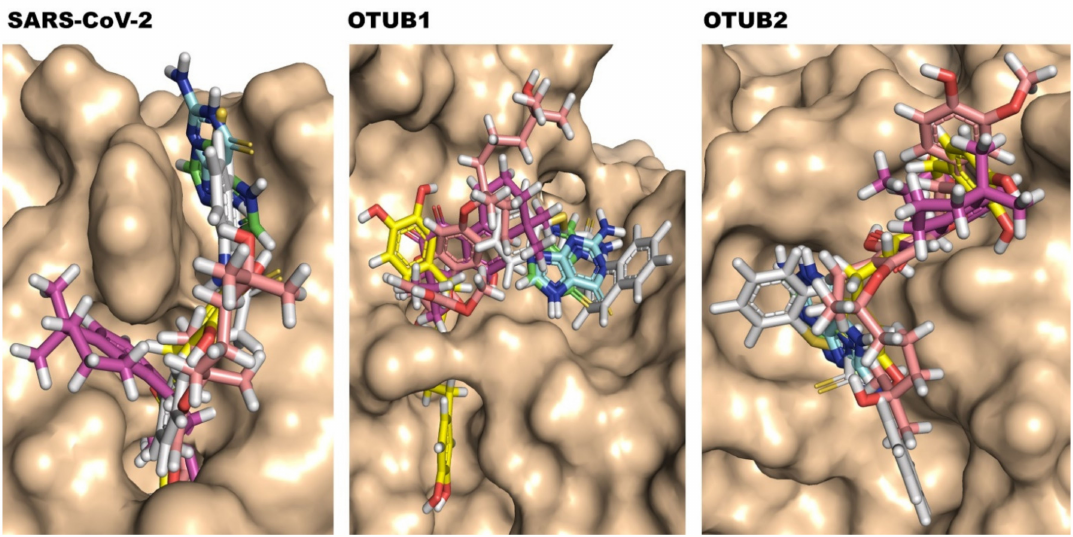
Figure 3. Top binding pose of selected SARS-CoV PLpro inhibitors docked into SARS-CoV-2 PLpro, OTUB1, and OTUB2 active sites. The protein is shown as surface and inhibitors are shown in the sticks with different colors (carbon atom) to differentiate them. Compound 1 in green, Compound 2 in aquamarine, Compound 3 in magenta, Compound 4 in yellow, Compound 5 in pink, and Compound 6 in grey.